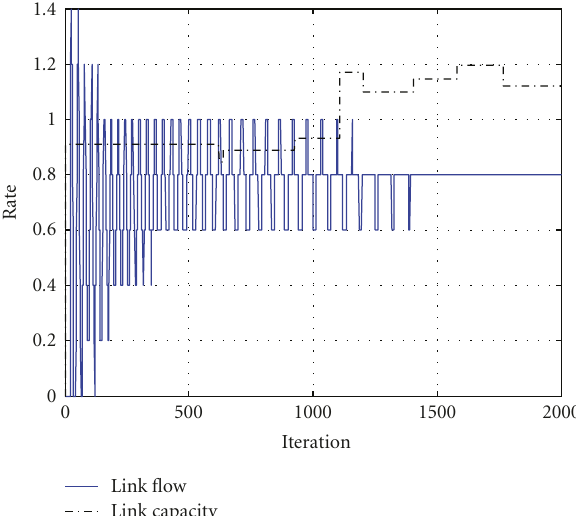
Figure 3: The flow and capacity of links 3 and 6.